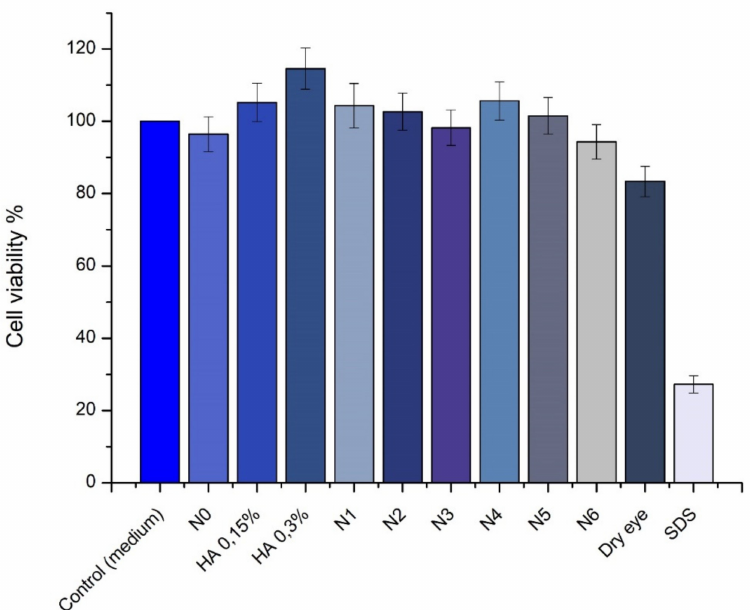
Figure 7. Cell viability of SIRC cell lines exposed for 24 h to hyaluronic acid 0.15% and 0.30% formulations and microemulsions containing royal jelly ( n = 5). When applied with 0.15% and 0.3% hyaluronic acid solutions, cell viability increased when compared to the dry eye model. The survival rates were over 100% indicating that the formulations were non-toxic providing a suitable environment for cell